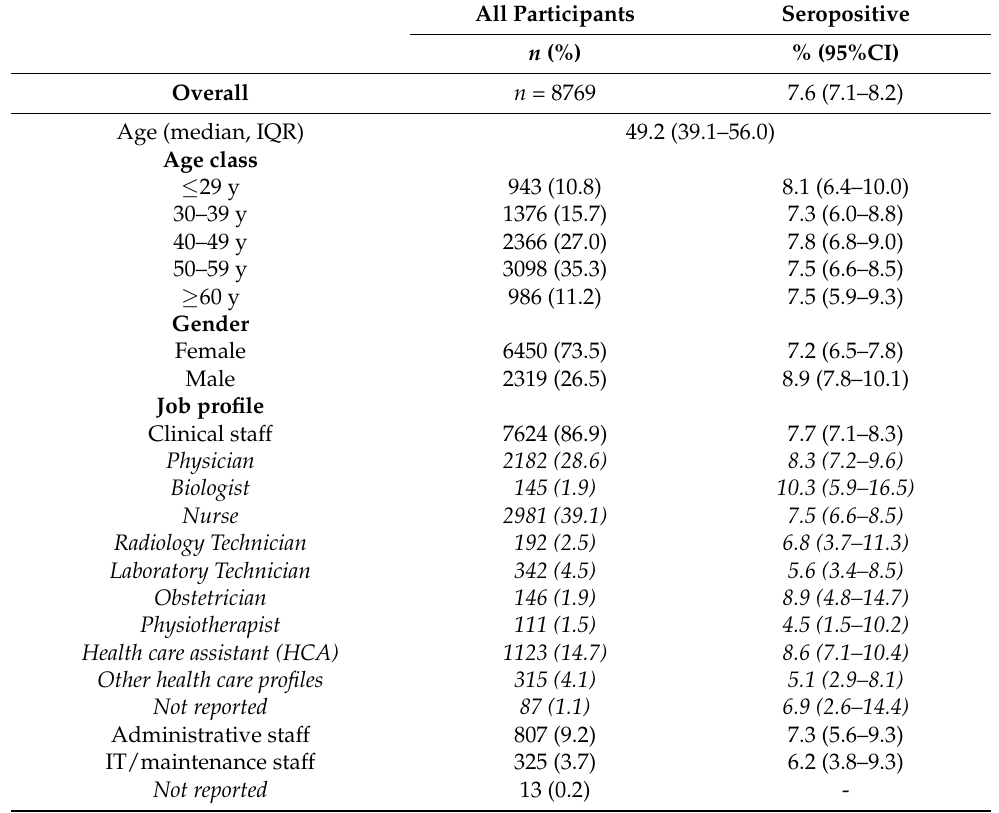
Table 1. Prevalence of seropositive by demographic, occupational, and clinical characteristics of study participants–CSS